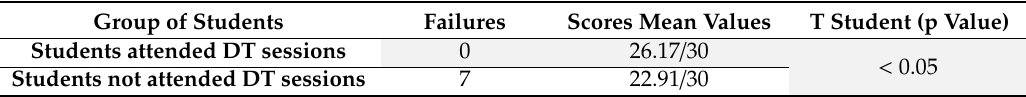
Table 3. Exam result of the nursing students. The two groups were compared on the basis of exam failure and on the exam score (final evaluation in 30s). The group of students who attended the DT session achieved better results than the other group of